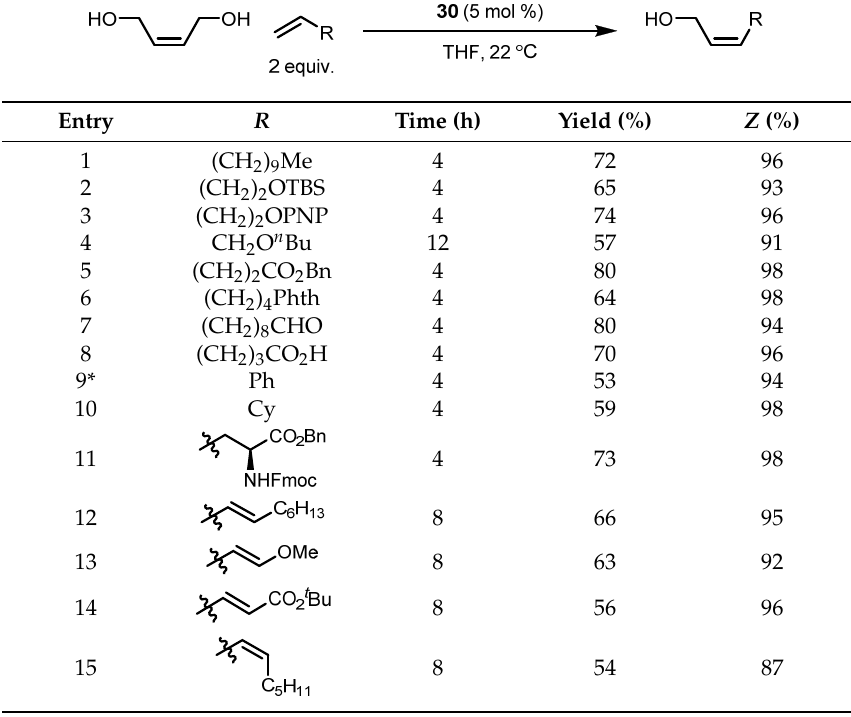
Table 11. CM scope of cis -1,4-butene diol with terminal olefins.